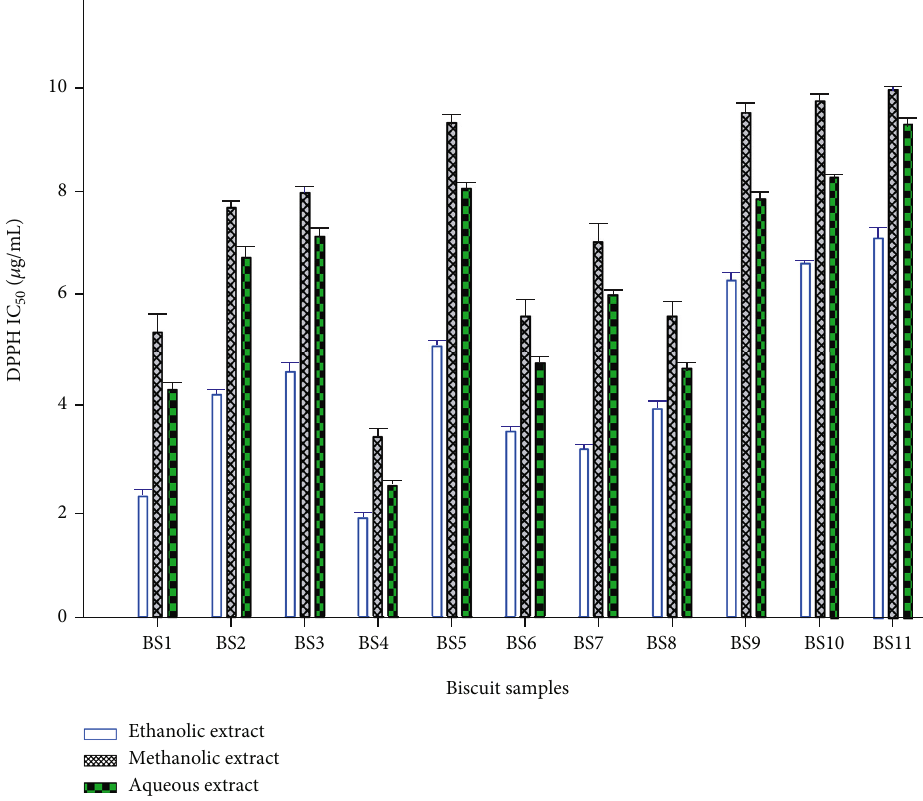
Figure 3: DPPH IC of the ethanolic and methanolic extracts of the di ff erent 50